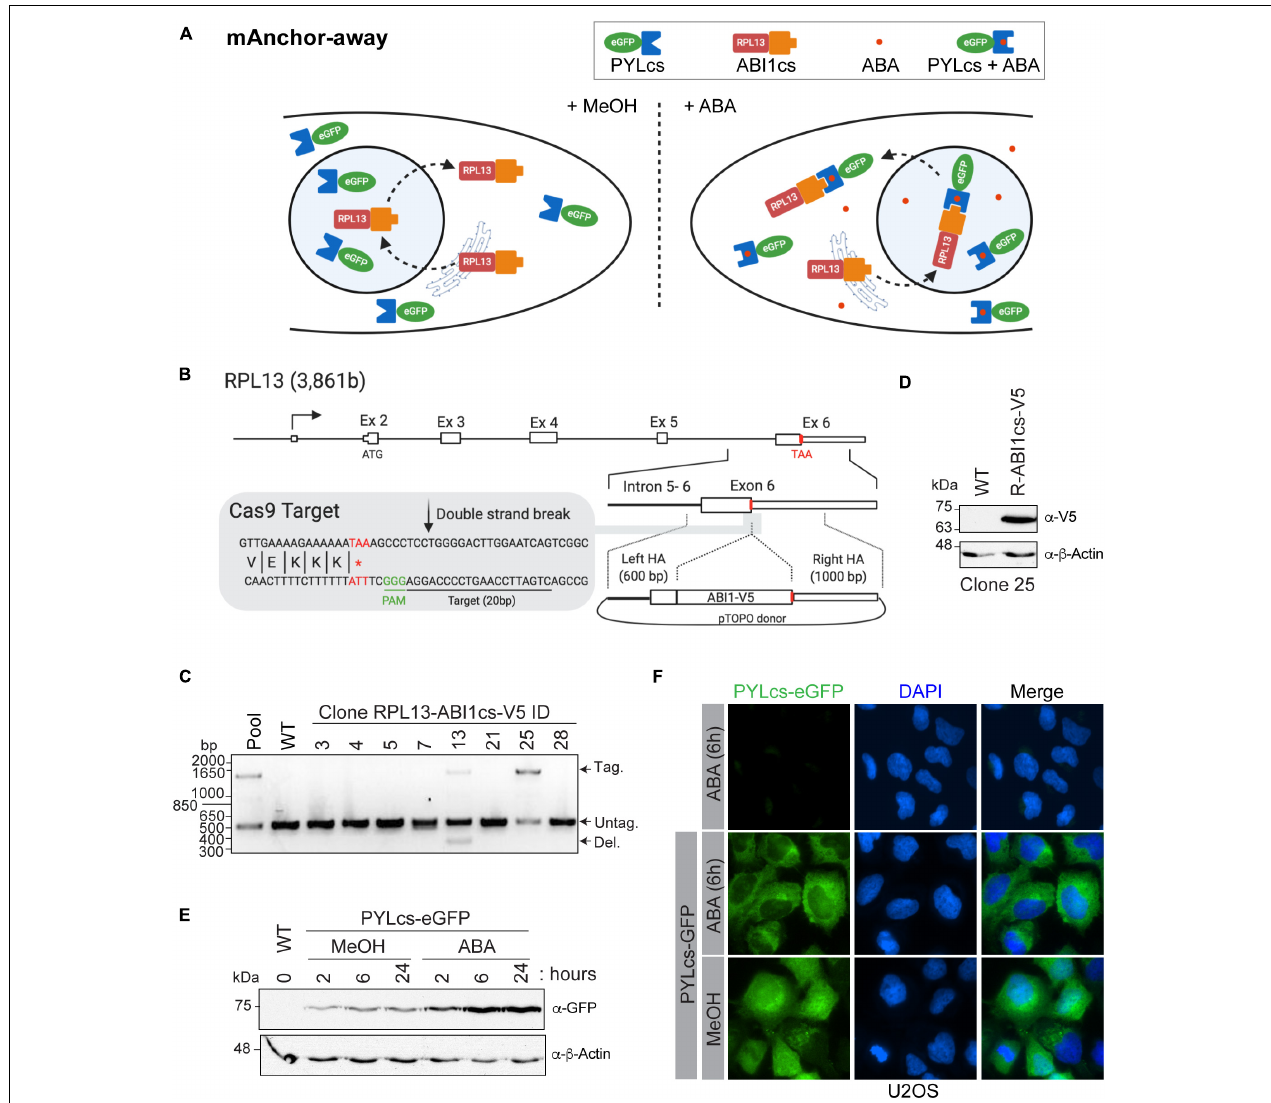
FIGURE 3 | A mammalian anchor-away system to quickly and efficiently deplete chromatin-modifying enzymes from the nucleus (A). Schematic of ABA-induced translocation of a nuclear protein to the cytoplasm. In the absence (or presence) of ABA, the ABI1cs-RPL13 fusion protein constantly shuttles between the cytoplasm and the nucleus like most ribosomal proteins, transiting to the nucleolus to assemble ribosome particles with the ribosomal RNA and then going back to the cytoplasm. Upon the addition of ABA, the dimerization of PYLcs-tagged protein with the ABIcs-RPL13 fusion protein triggers its rapid depletion from the nucleus to the cytoplasm, as “anchored away” by the RPL13 ribosomal protein. (B) Strategy to establish U2OS cell lines expressing RPL13-ABI1cs-V5 from the endogenous locus. The RPL13 locus, the Cas9 cleavage site, and the donor construct are indicated. The sequence of the sgRNA targeting RPL13 is underlined, and the stop codon is indicated in red. HA: homology arm. (C,D) Characterization of RPL13-ABI1cs-V5 isogenic cell lines. (C) Results of an out-out PCR-base assay conducted on U2OS genomic DNA to detect ABI1cs-V5 integration at the RPL13 locus. The primers are located in the homology arms and yield a longer PCR product if ABI1cs-V5 is integrated (1,452 bp vs 510 bp for the wild-type allele). In panel (D) , whole-cell extracts of wild type U2OS cells and those expressing RPL13-ABI1cs-V5 (clone #25) were western blotted with an anti-V5 antibody to confirm RPL13-ABI1cs-V5 expression (top panel). β -actin was used as a loading control (bottom panel). (E) Whole-cell extracts of U2OS RPL13-ABI1cs-V5 cells stably expressing PYLcs-eGFP from the AAVS1 locus. Samples were collected at the indicated times following treatment with 100 µ M ABA (0.1% MeOH was used as a negative control). An anti-GFP antibody was used to detect PYLcs-eGFP (top panel) and β -actin was used as a loading control (bottom panel). (F) Immunofluorescence of U2OS cells expressing either RPL13-ABI1cs-V5 alone (clone #25, as a negative control) or RPL13-ABI1cs-V5 and PYLcs-eGFP. Cells were treated with either 100 µ M ABA or 0.1% MeOH. DNA was stained with DAPI.